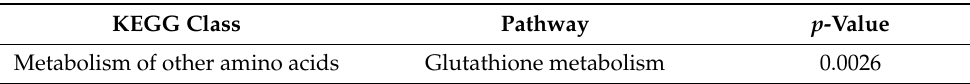
Table 3. KEGG terms enriched among downregulated DEGs specific to the TS vs. TP comparison. KEGG